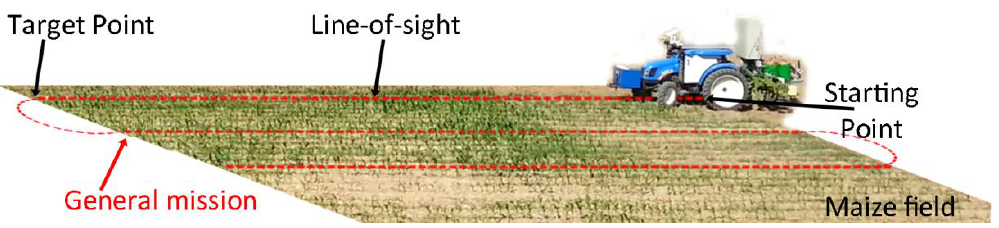
Figure 6. Example of path planning in the maize